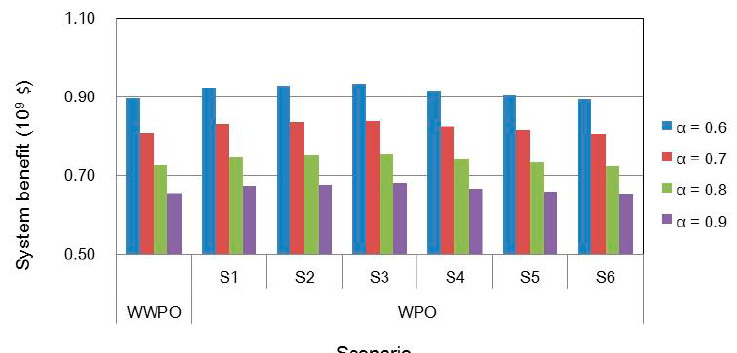
Figure 9. System benefits based on various initial water-rights allocations under various scenarios when α levels are 0.6, 0.7, 0.8 and 0.9 (WWPO denoted initial water-rights allocation based on previous water intake permits, WPO denoted as initial water-rights allocation with the IWRA model).